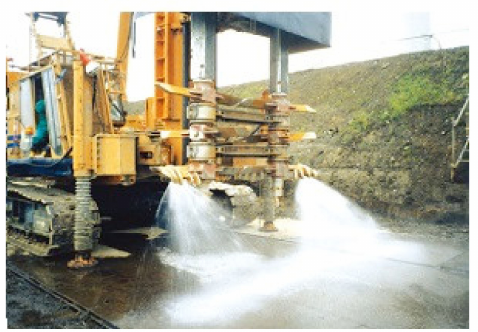
Figure 10. Mixing machine injecting atomized cement slurry [16].